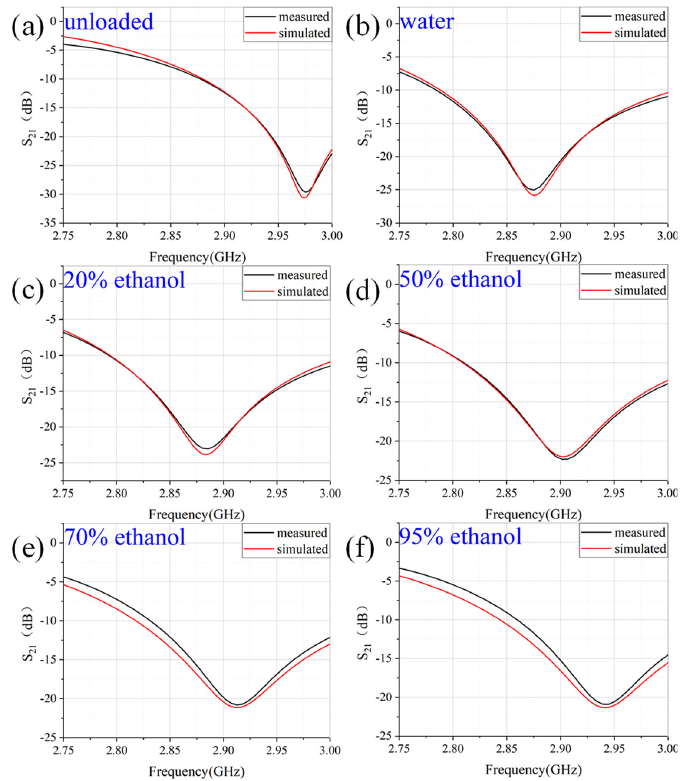
Figure 13. Comparison between measurement and simulation of S 21 ( a ) unloaded; ( b ) 0% ethanol (water); ( c ) 20% ethanol; ( d ) 50% ethanol; ( e ) 70% ethanol; ( f ) 95% ethanol.